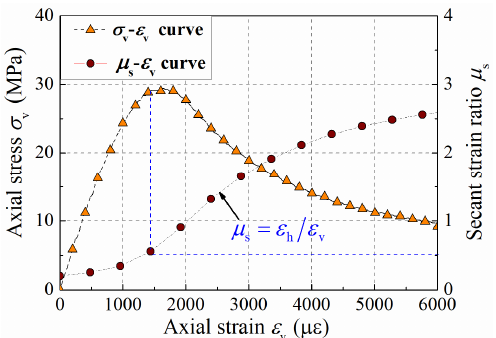
Figure 6. Secant strain ratio of concrete under axial load.